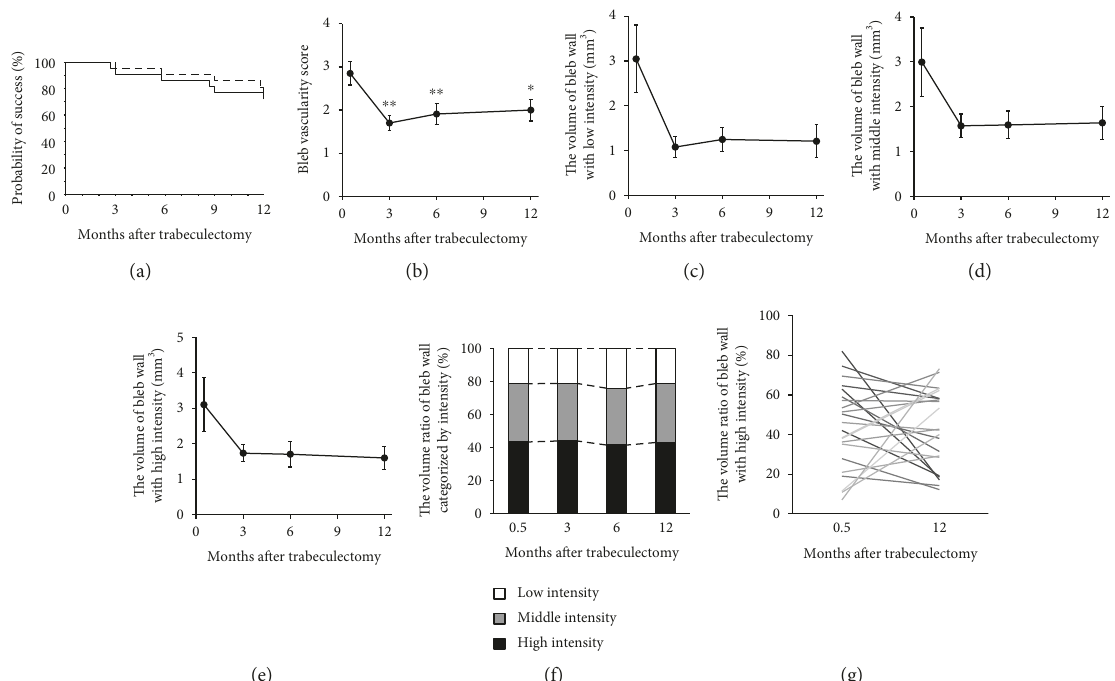
Figure 3: Time-dependent changes in IOP control and bleb parameters. (a) The probability of surgical success (IOP control between 4 and 21mmHg) based on complete (solid line) and quali fi ed success (dashed line). (b) Time-dependent changes in bleb vascularity score (c, d, e) changes in bleb wall intensity assessed by 3D AS-OCT. Each bleb wall was coded based on optical density: low (c), middle (d), and high (e) intensities. (f) Time-dependent change in the volume ratio of each category was assessed by averaging. (g) Time-dependent change in the high-intensity volume ratio in each eye. ∗ P < 0 05 ; ∗∗ P < 0 01 compared with the value 0.5 months after